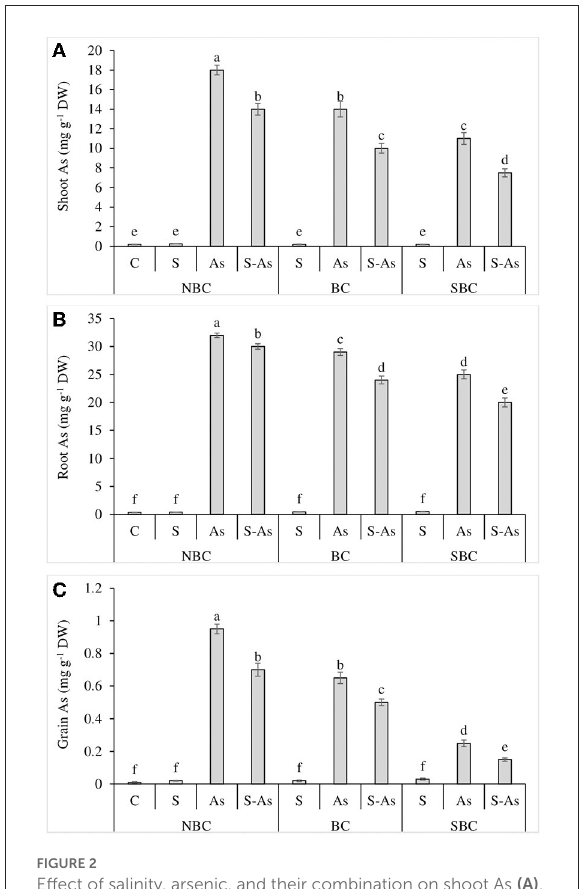
FIGURE2 Effect of salinity, arsenic, and their combination on shoot As (A) , root As (B) , and grain As (C) concentration of quinoa supplemented with no biochar (NBC), biochar (BC), and silicon-nanoparticles doped biochar (SBC). The values (average ± SE of four replicates) followed by different letters represent the significant difference at a significance level of 5%.